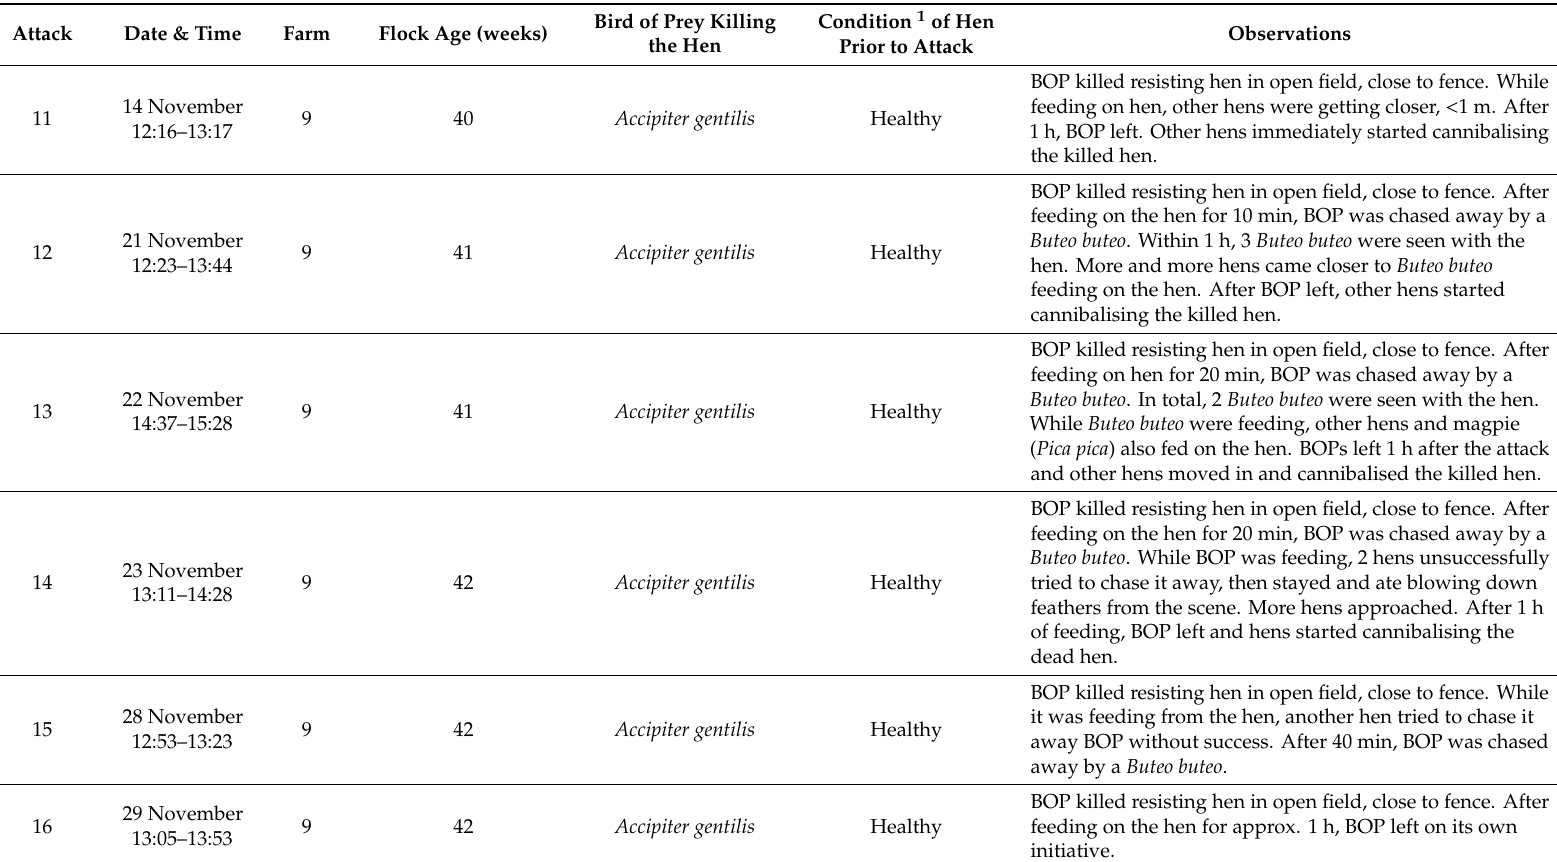
Table 6. Attacks on hens by birds of prey (BOP) filmed with camera, numbered in chronological order. Bird of Prey Killing Condition 1 of Hen Attack Date & Time Farm Flock Age (weeks) the Hen Prior to Attack